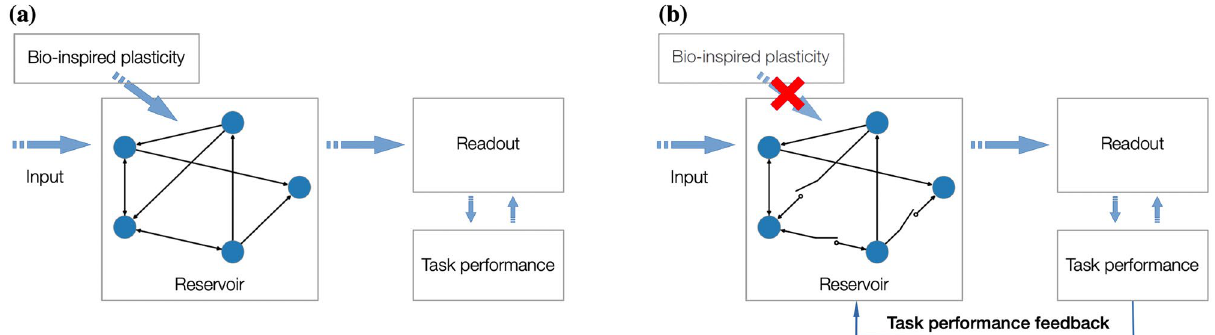
Figure 1. Two approaches for reservoir computing. (a) Bio-inspired plasticity is used to adjust the structural and dynamical properties of the reservoir in the unsupervised fashion. (b) Task performance feedback is used